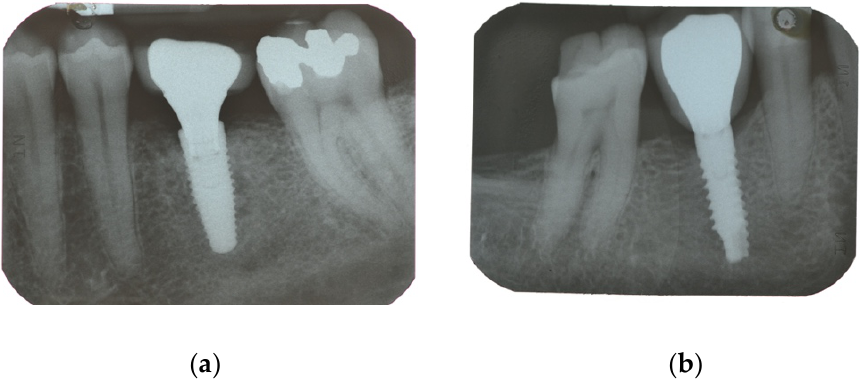
Figure 2. Radiographs when the screw-retained restoration was delivered ( a ) Nobel Parallel; ( b ) Prama Sweden & Martina.